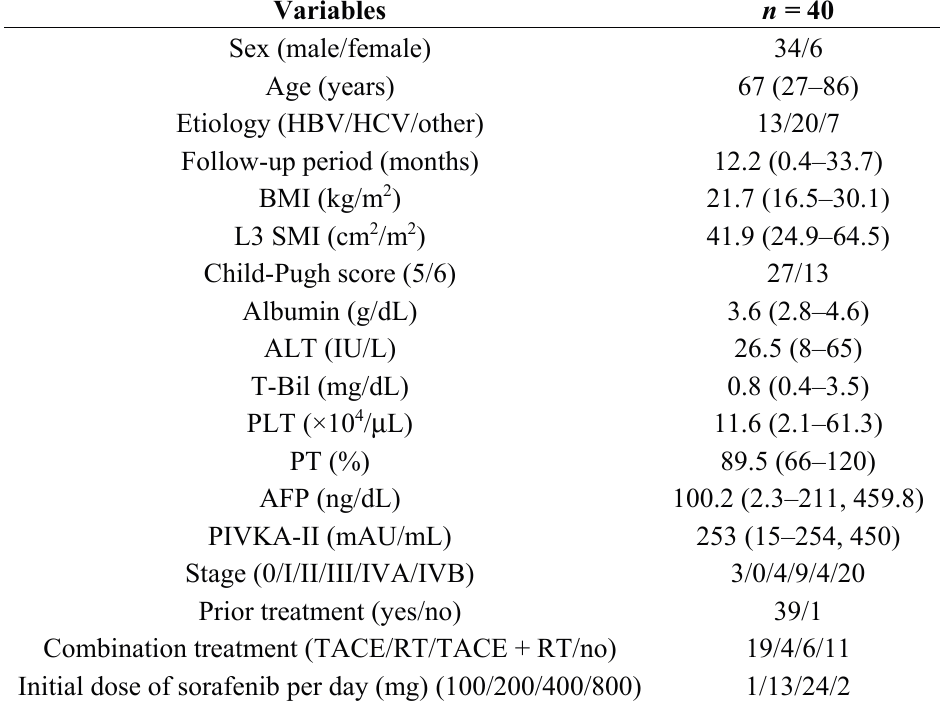
Table 1. Baseline demographic and clinical